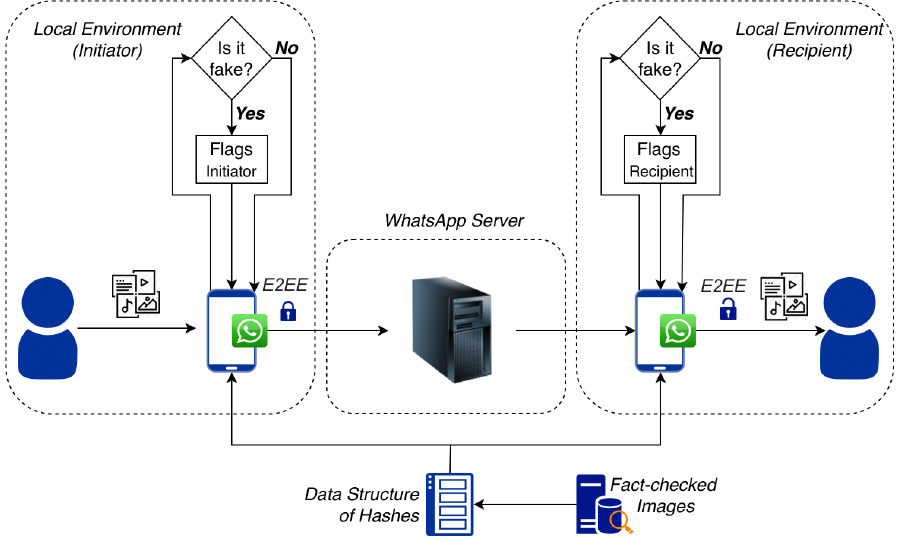
Figure 1. Proposed architecture for on-device